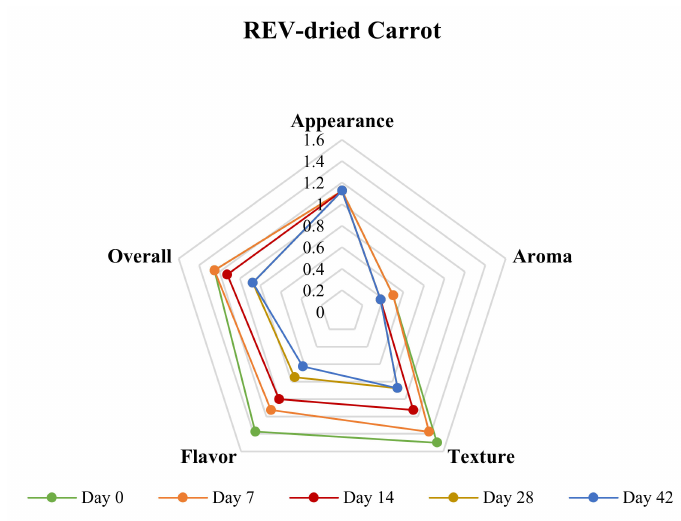
Figure 8. Cobweb diagram of five sensory attributes of REV-dried broccoli, orange, and carrot over the accelerated shelf life study based on panelists’